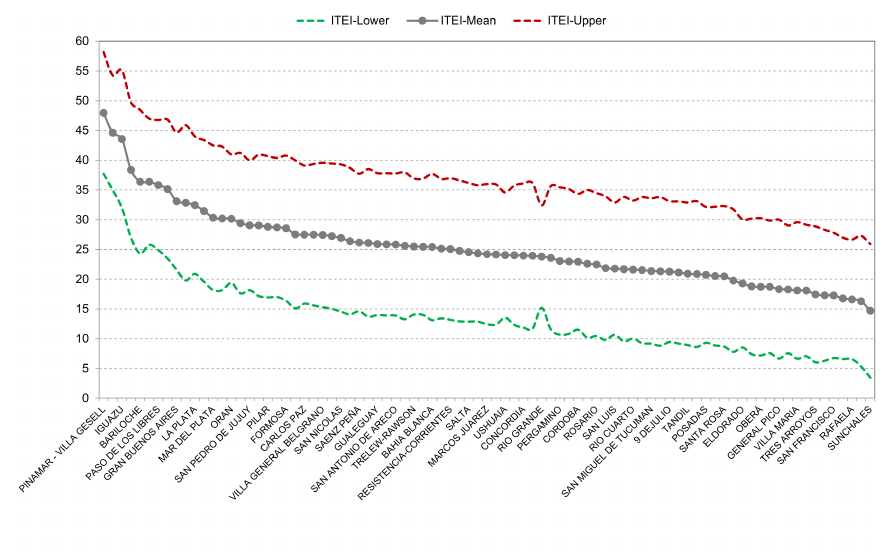
Figure 3: Lower, upper, and average ITEI for LMAs